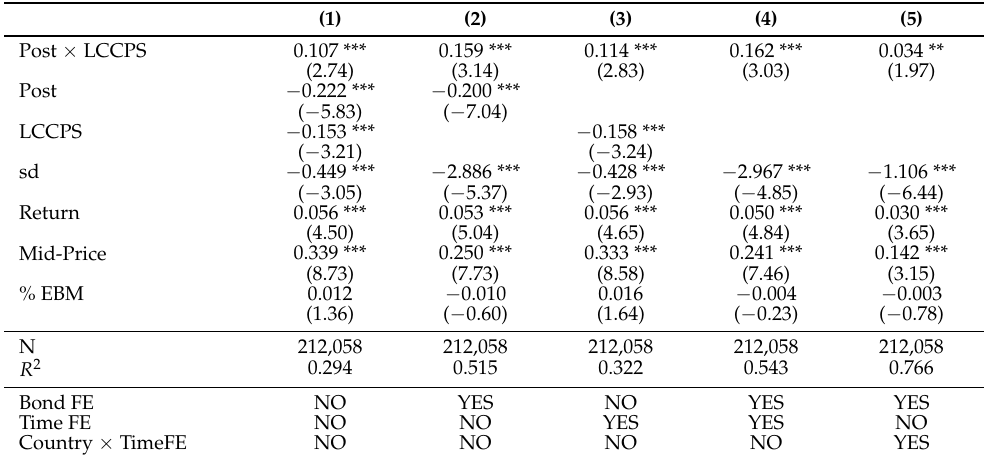
Table 8. Difference-in-difference with bid–ask